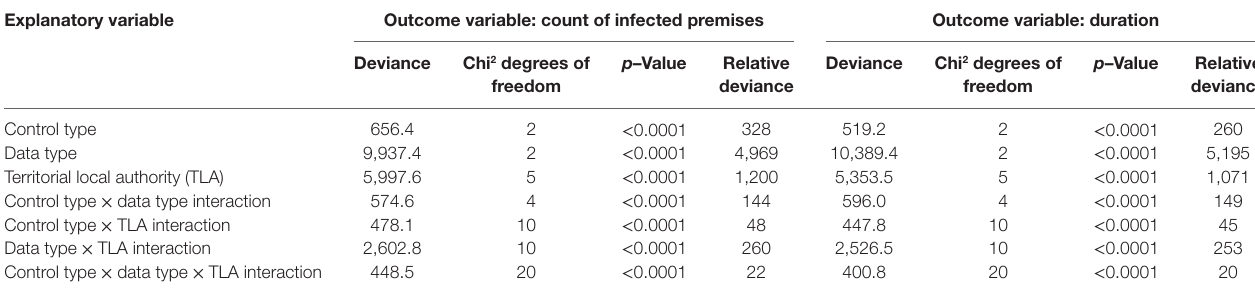
Table 6 | Analysis of variance (ANOVA) table for the cox proportional hazards (CPH) models with infected premises (IPs) and duration as outcome variables. explanatory